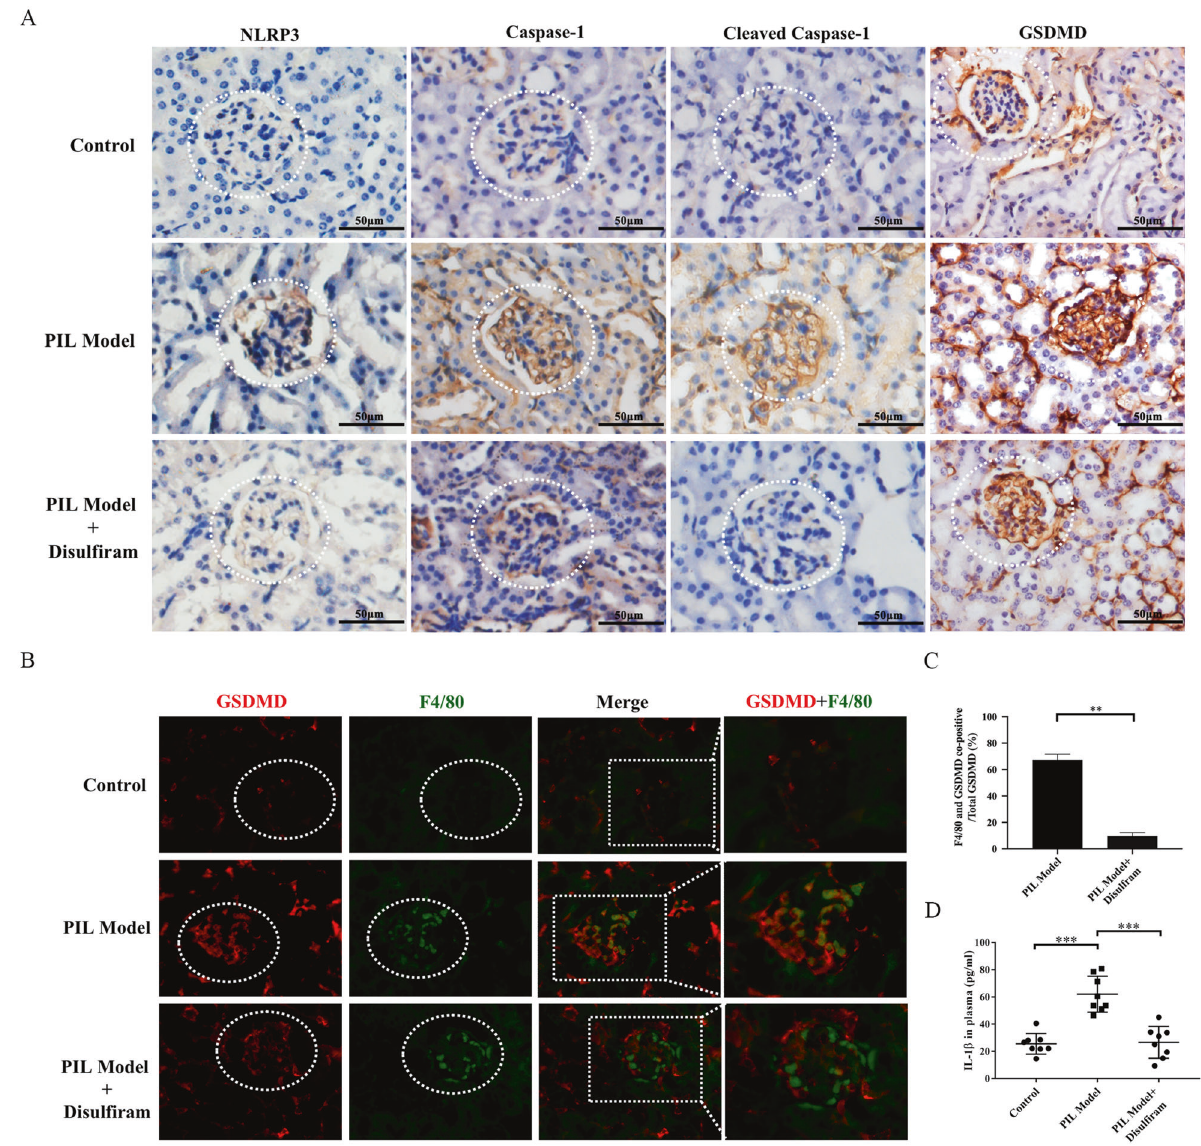
Fig. 4 DSF reduced the level of serum IL-1 β and inhibited glomerular macrophage pyroptosis in PIL mice. A Representative immunohistochemical staining images of NLRP3, caspase-1, cleaved caspase-1 and GSDMD in the kidneys. B Double immuno fl uorescence staining of glomerular macrophages (green) and GSDMD (red) in each group. F4/80 represented macrophages. C GSDMD in monocytes/ macrophages as a proportion of total GSDMD was calculated. D The level of serum IL-1 β in each group was detected by ELISA. n = 8 animals for each group. Each experiment was repeated three times. Signi fi cant differences were calculated using one-way ANOVA. Values were shown as mean ± SD. ** p < 0.01, *** p < 0.001. PIL pristane-induced lupus. DAPI 4 ′ ,